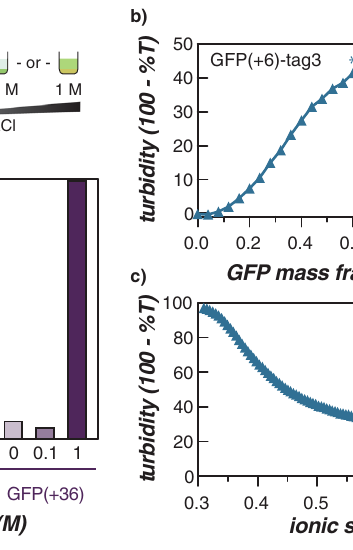
error bars represent the standard deviation of three technical replicates. Micro- scopy images (right) depict the GFP channel image of the GFP/RNA mixture at 0.6 (top) or 0.88 (bottom) GFP mass fraction, which demonstrated the highest tur- bidityorformationofindividualdropletsthatdidnotcoalesceonthesurfaceofthe plate, respectively. Scale bars are 10 µ m. c NaCl titration wasconductedat 0.6 GFP mass fraction in 1ml total volume of GFP/RNA mixture prepared from 1mg/ml